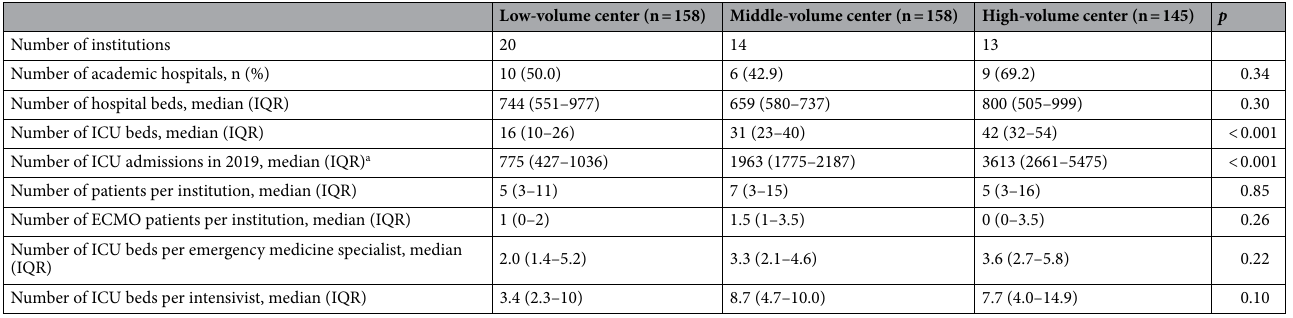
Table 1. Institutional information. IQR interquartile range, ICU intensive care unit. a ICU admissions from January to December